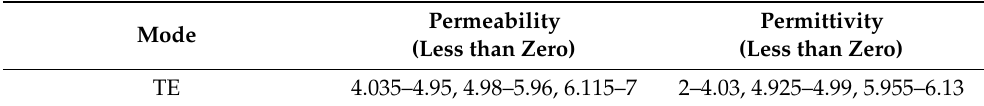
Figure 6. Metamaterial property of proposed absorber in the TE mode, ( a ) permeability, ( b ) permit- tivity, and ( c ) refractive index plots. Table 3. Permeability and permittivity (real values) at different Table 4. Metamaterial property (real and imaginary values) at the resonant frequency.